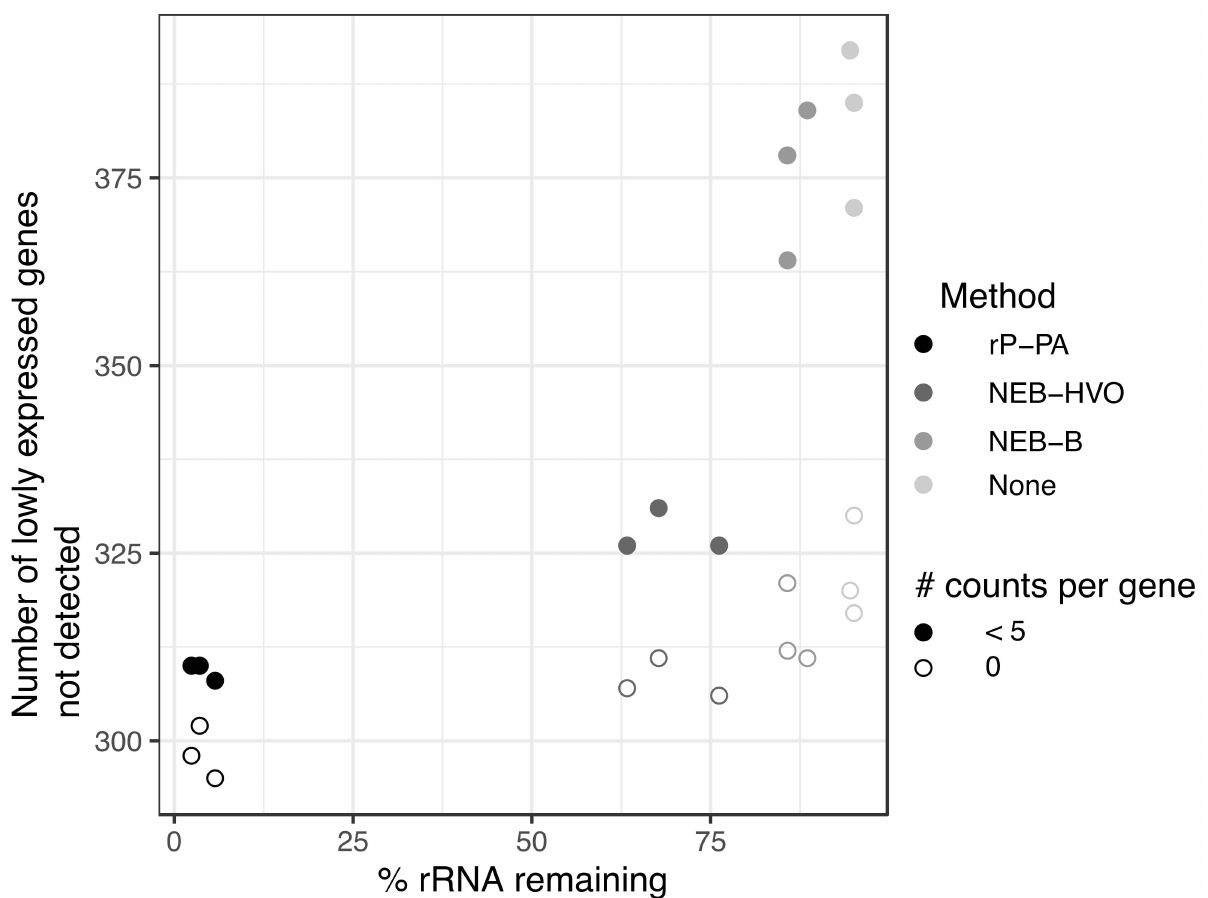
Figure 8. More complete rRNA removal leads to increased detection of lowly expressed genes. Number of genes with zero (open circles) and <5 (filled circles) reads detected in sequencing samples treated with different rRNA removal methods in Hbt. salinarum . The darker the circle color, the more complete the rRNA removal for each method: riboPOOL Panarchaea (rP-PA, black); NEBNExt with HVO-specific probes (NEB-HVO, dark grey); NEBNext with bacterial probes (NEB-B, grey); no removal (none, light